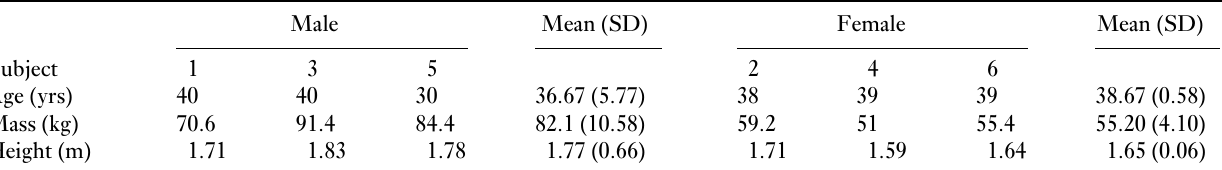
Table 1 The demographic characteristics of the research